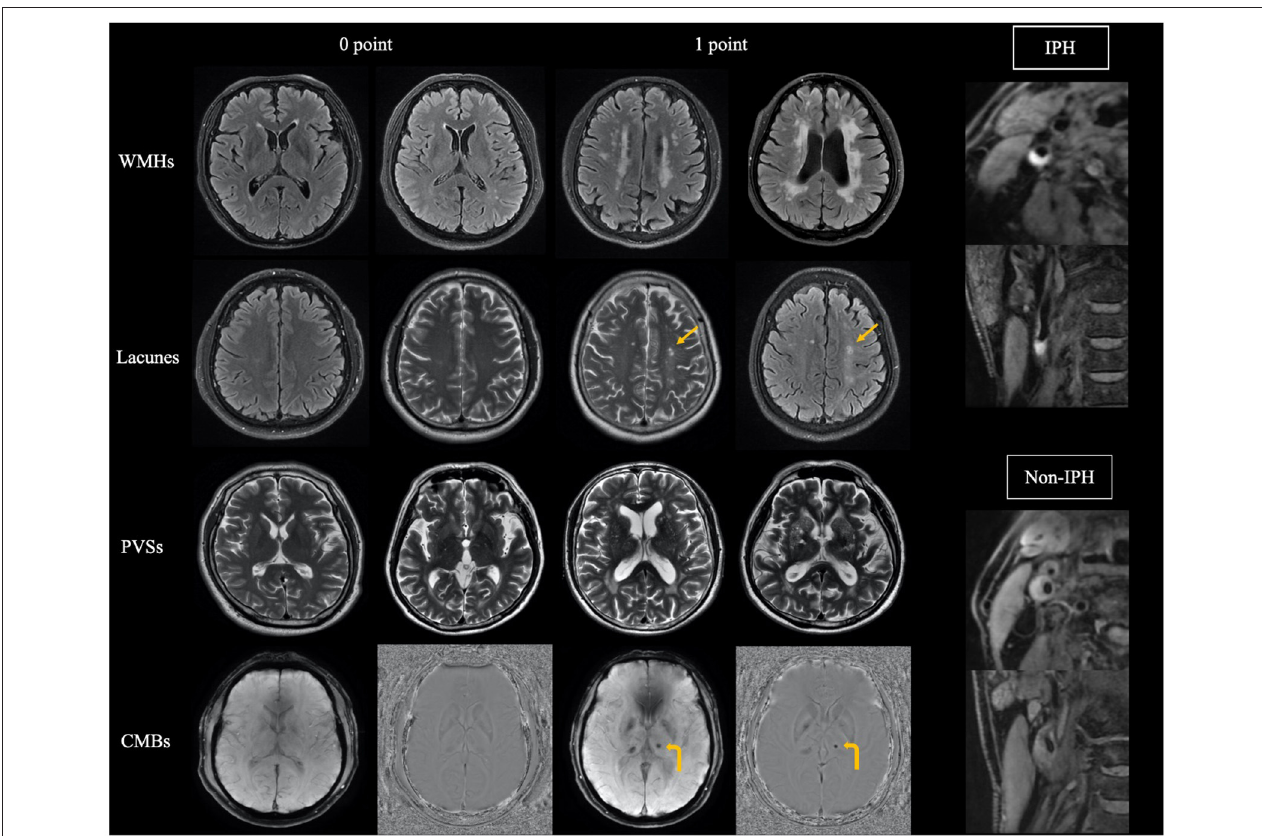
FIGURE 2 | Reference images of total cerebral small vessel disease burden and carotid intraplaque hemorrhage (IPH). Arrow indicates lacunes, and curved arrow indicates cerebral microbleeds. WMHs, white matter hyperintensities; PVSs, perivascular spaces; CMBs, cerebral